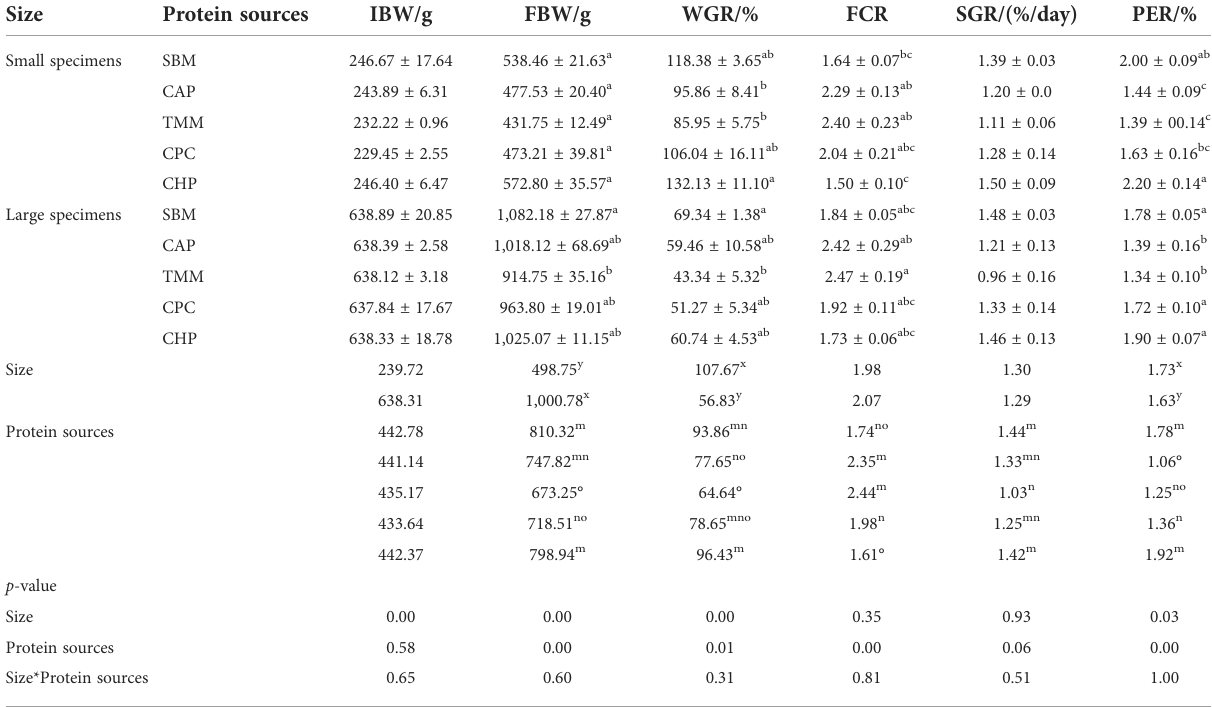
TABLE 4 Growth performance and feed conversion of grass carp in different treatments.